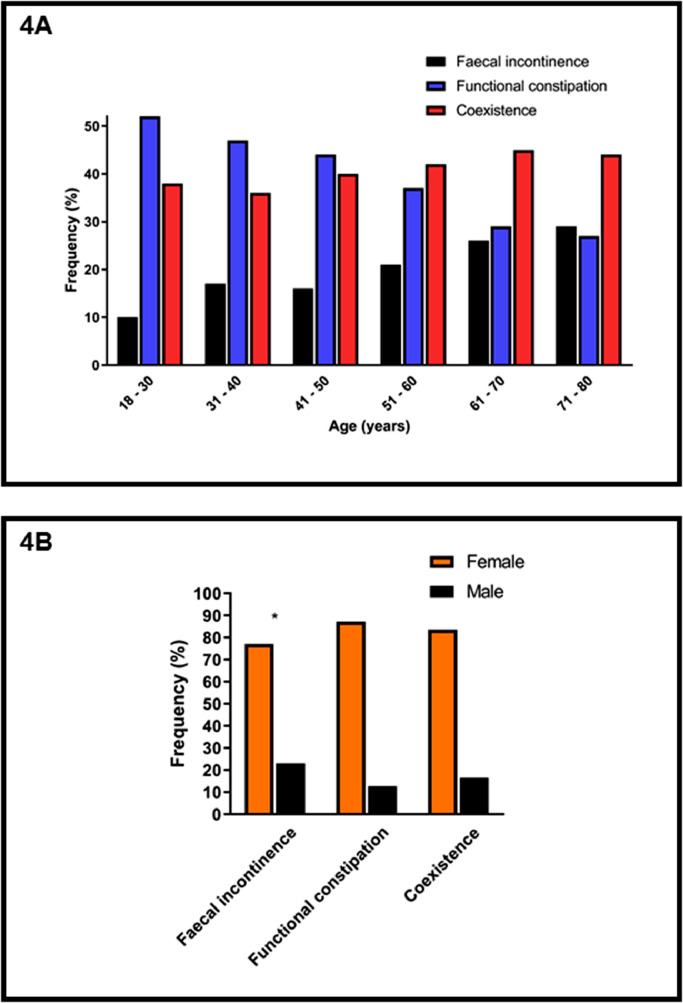
Proportions of patients with self-reported symptoms of faecal incontinence in isolation, functional constipation in isolation and coexistent faecal incontinence and functional constipation according to the Rome IV core criteria in 4027 patients: A Effect of age. B. Effect of sex. The proportion of males was higher in patients with faecal incontinence in isolation compared to patients with functional constipation in isolation or coexistent symptoms (* p <0·0001).